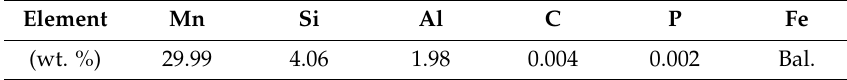
Table 1. Chemical composition of the experimental